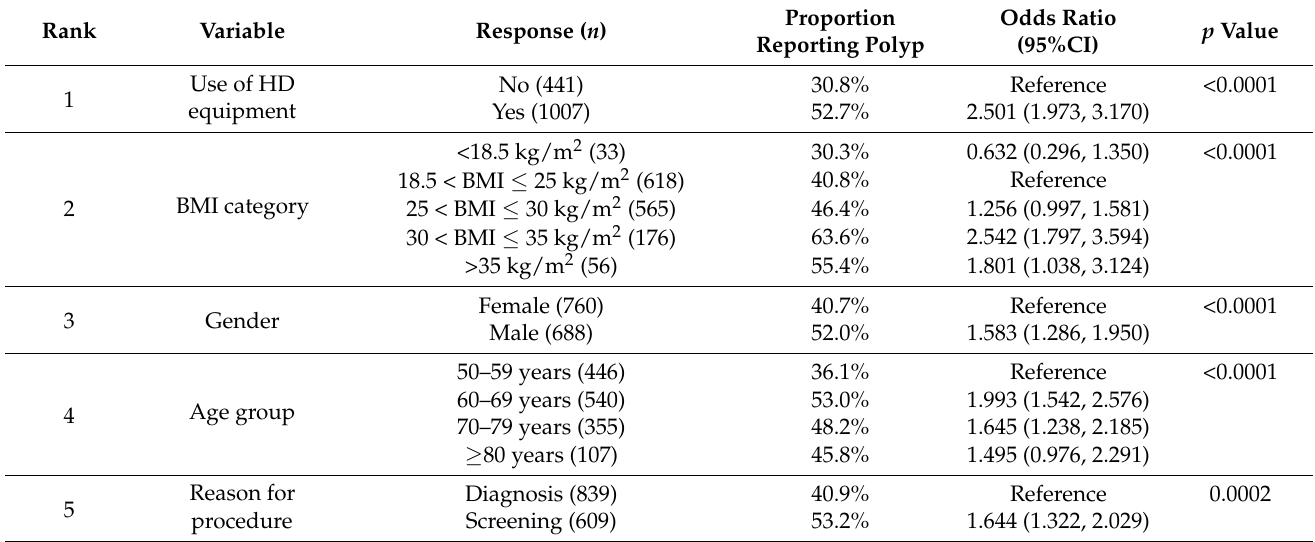
Table 2. Results of stepwise analysis on 1448 procedures with all pre-specified variables